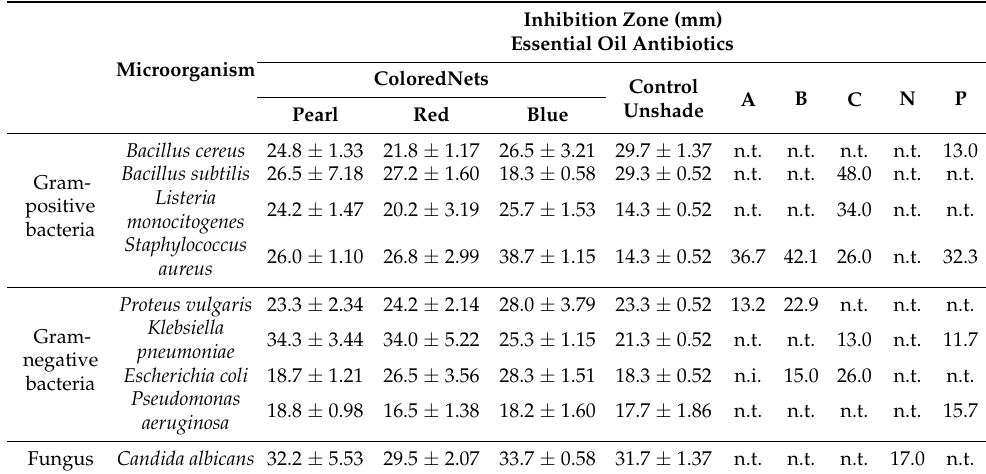
Table 3. Antimicrobial activity (inhibition zone, mm) of the basil essential oils in comparison to commercial